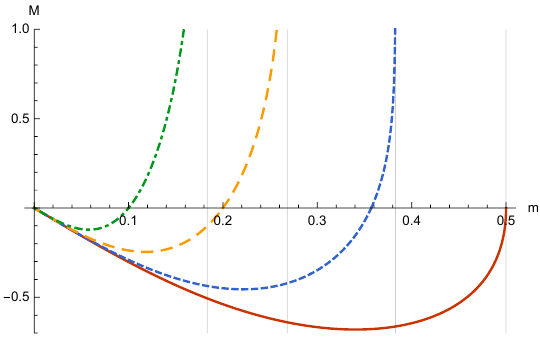
Figure 23 . A plot of 8 παM at various values of A ‘ : A ‘ = 2 . 0 (solid red), A ‘ = 2 . 8 (dotted blue), A ‘ = 5 . 0 (dashed orange), A ‘ = 10 (dot-dashed green). The grey vertical lines denote the asymptotes where the divergences A ‘ = ( m sin( mπ )) − 1 are met. Negative values of M are forbidden by the lower bound m ≥ ( A ‘ ) − 1 .